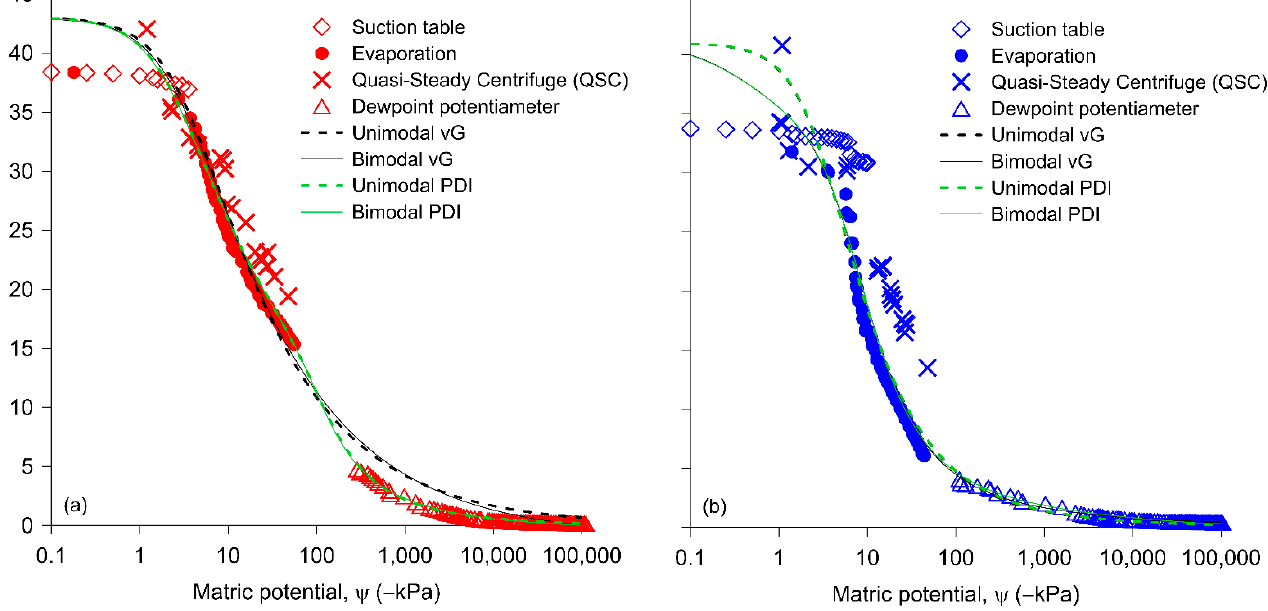
Figure 3. Measured and fitted rock water retention curves of lithotypes C ( a ) and M ( b